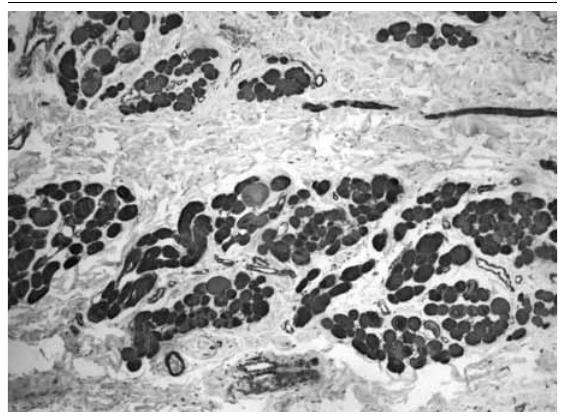
IHC: immunohistochemical.